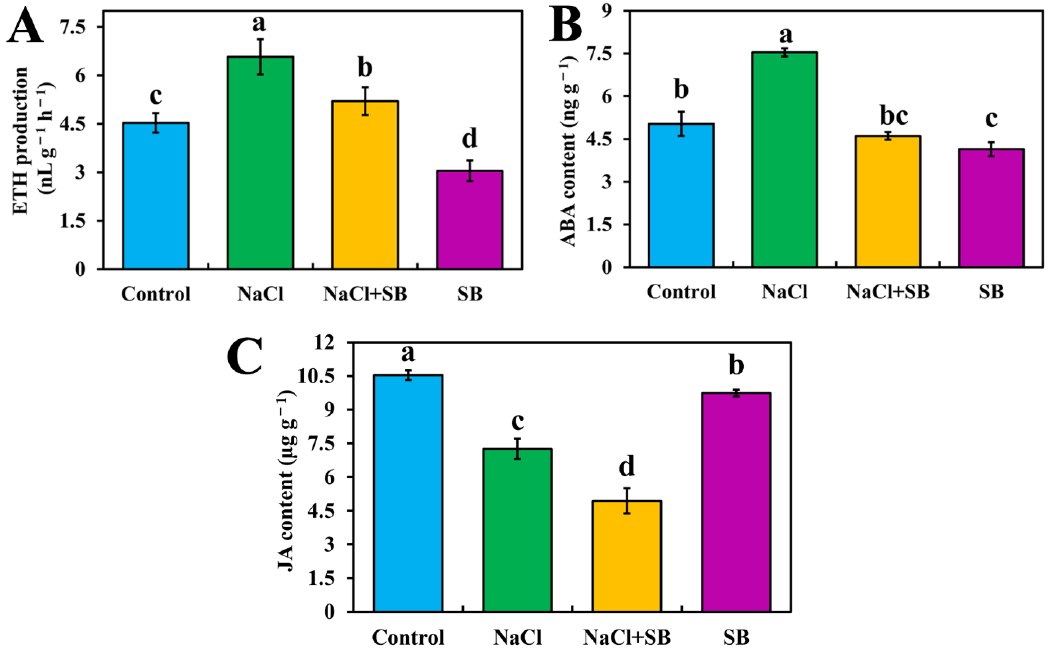
Figure 5. Effect of MAPK inhibitors SB203580 on the levels of endogenous hormones during salt stress. ( A ) ETH production, ( B ) ABA content, ( C ) JA content. The values (means ± SE) are the averages of three independent experiments ( n = 15). Bars not sharing the same letters indicate statistically significant differences according to Duncan’s multiple range test ( p < 0.05).